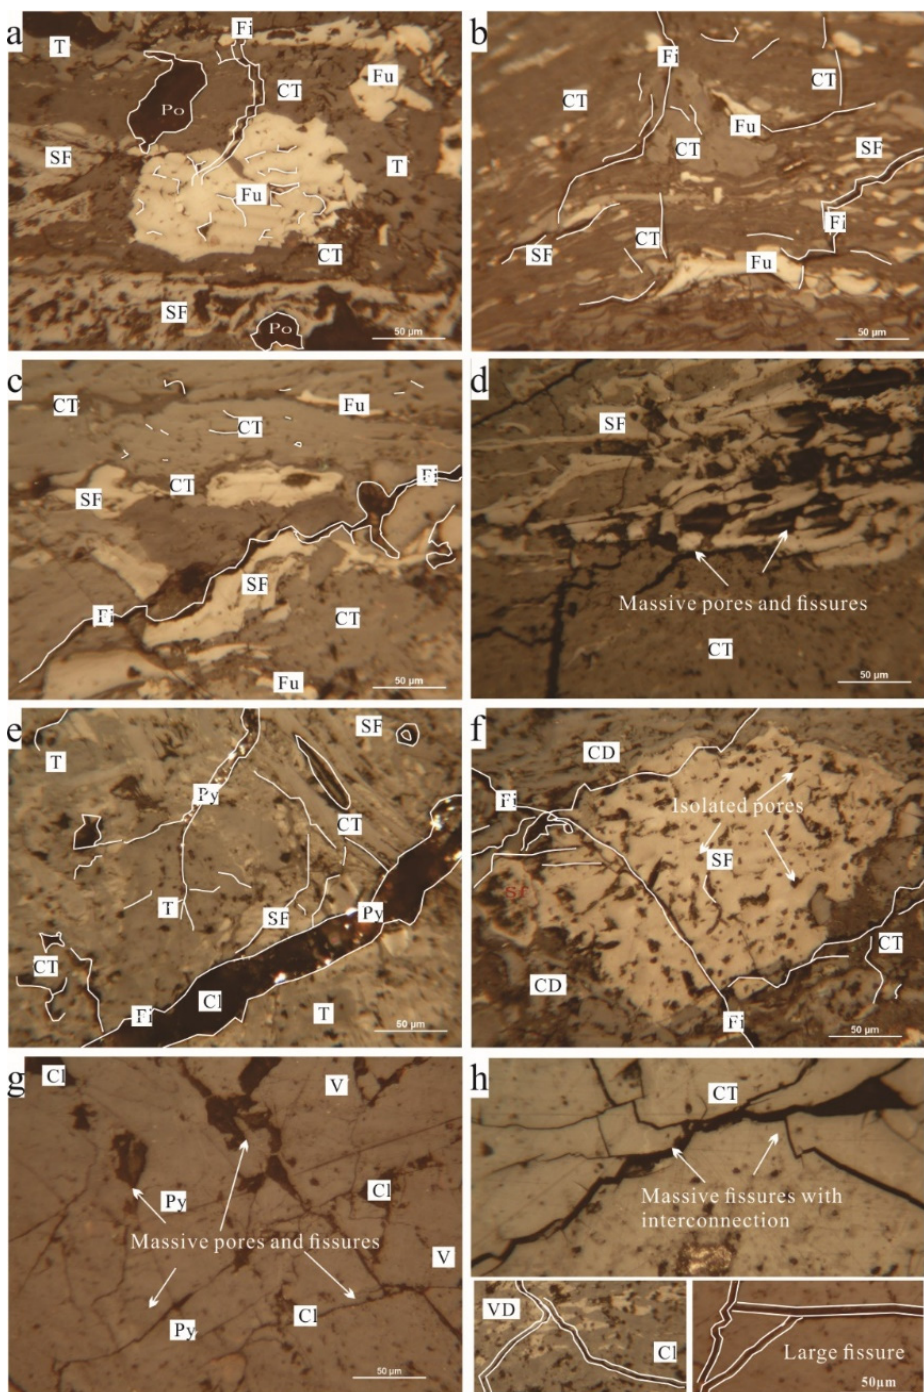
Figure 8. Photomicrographs of pore and fissure characteristic in the maceral group. ( a – c ) Sample QH1; ( d ) Sample CL1; ( e ) Sample CL2; ( f ) Sample QY2; ( g ) Sample SS1; ( h ) Sample HD1. T = telinite; SF = semifusinite; Fu = fusinite; CT = collotelinite; CD = collodetrinite; V = vitrinite; VD = vitrodetrinite; Po = pore; Fi = fissure; P =pyrite; Cl = clay.